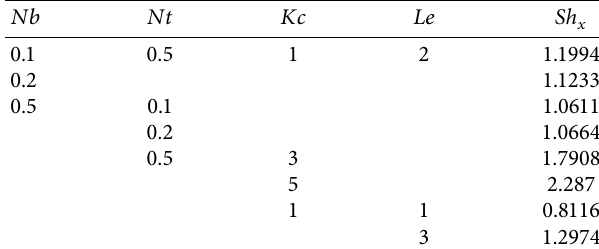
Table 3: Sherwood